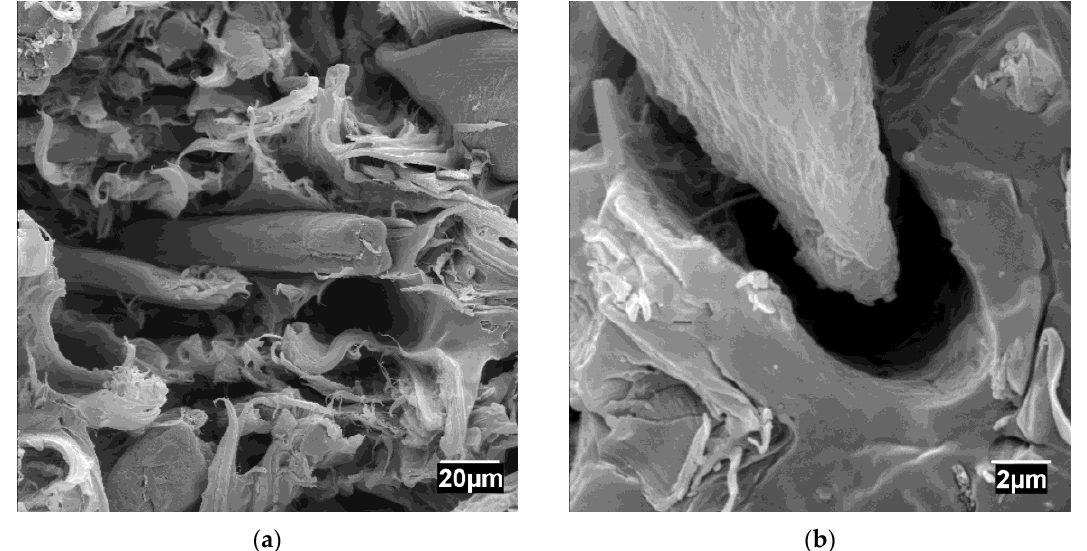
Figure 4. SEM micrographs of uncoupled PP composites reinforced with 40 wt % at di ff erent resolutions: ( a ) Detail of the dispersion of the ONPF fibers in the matrix and some possible pullout fibers; ( b ) Detail of a void in the fiber matrix interface.